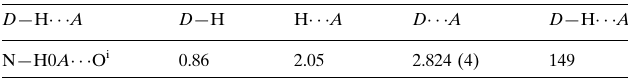
Hydrogen-bond geometry (A˚ , (cid:4)